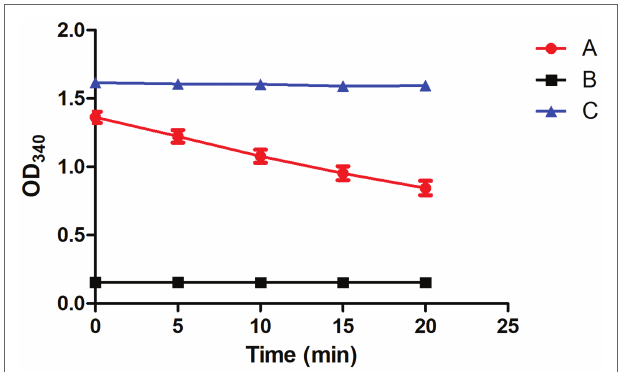
FIGURE 5 | Detection of the mitochondrial activity by the respiratory chain. (A) A complete system containing the extracted mitochondria. (B) Negative control, NADH not included. (C) Positive control, fumarate not included. Error bars represent SDs ( n = 3).